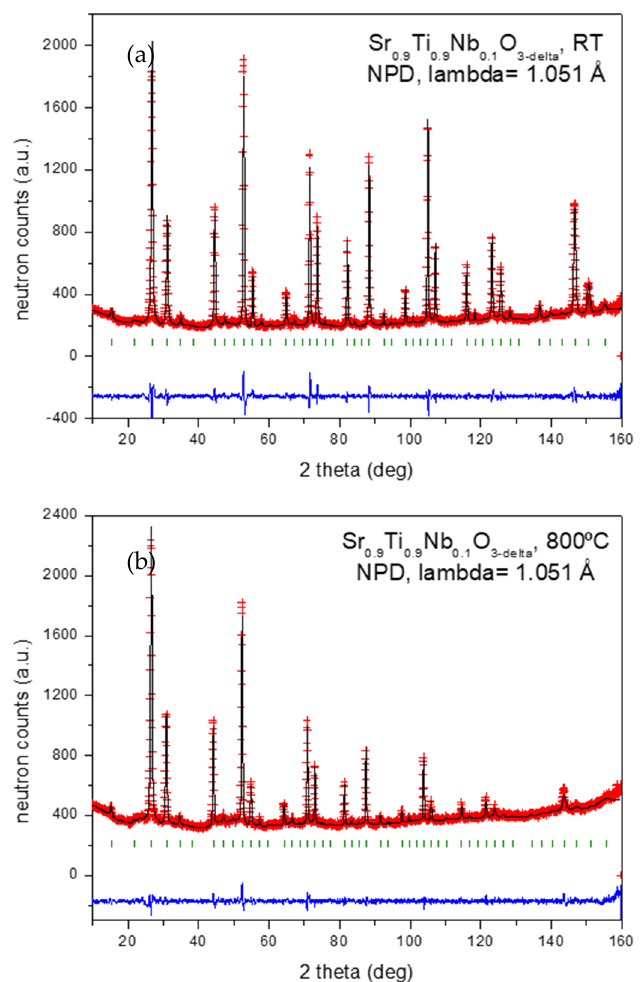
Figure 1. Observed (red crosses), calculated (black line), and difference (lower blue line) Neutron Powder Diffraction (NPD) profiles for ( a ) Sr 0.9 (Ti 0.9 Nb 0.1 )O 3-δ, at 25 and ( b ) 800 °C. The allowed Bragg positions are shown as green vertical marks.